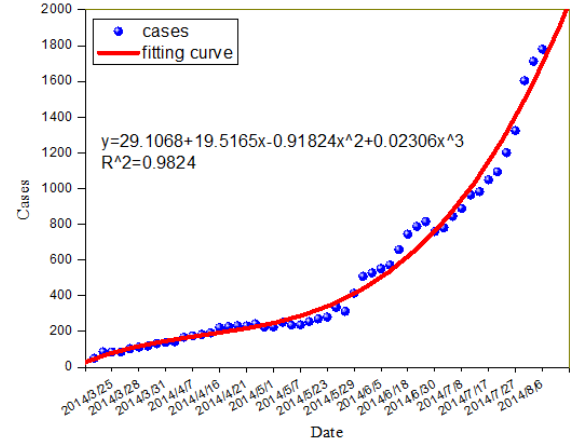
Figure 2. Statistics of global Ebola Trend curve from March to June,